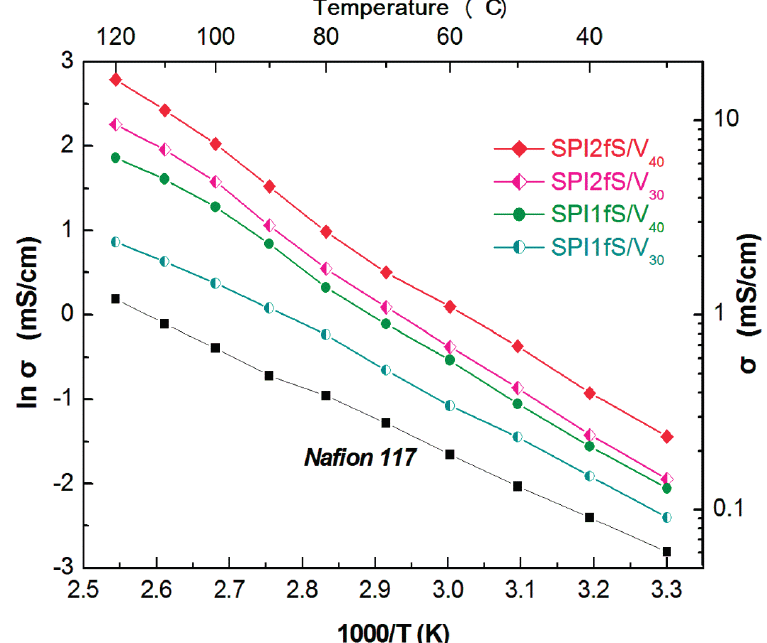
Figure 7. Arrhenius plot for the temperature-dependent conductivities of Nafion 117 and SPIs doped with PIL 30% and 40% under ambient